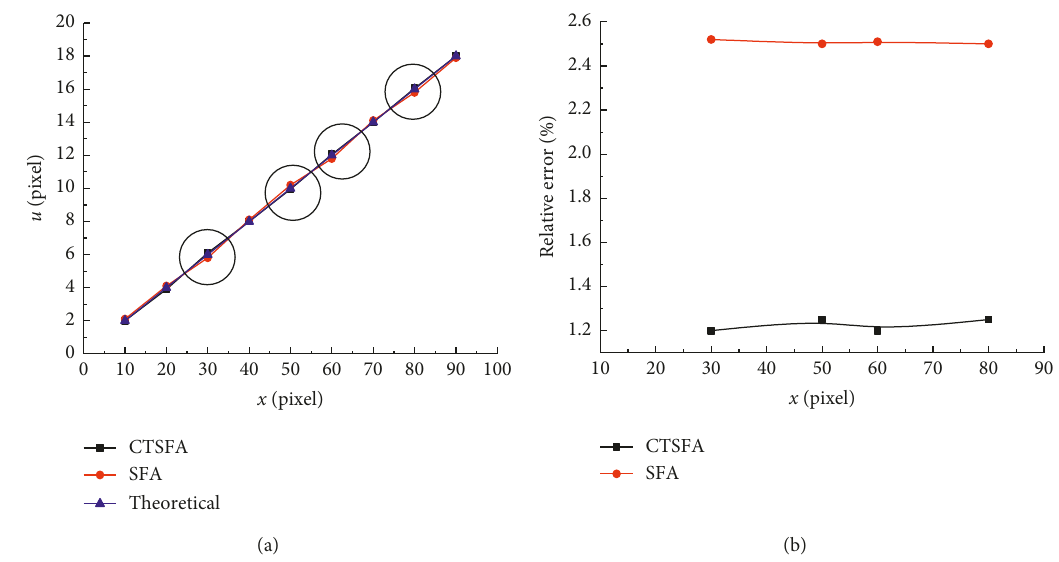
Figure 7: Results of uniform displacement field. (a) Comparison of displacement values. (b) Comparison of relative